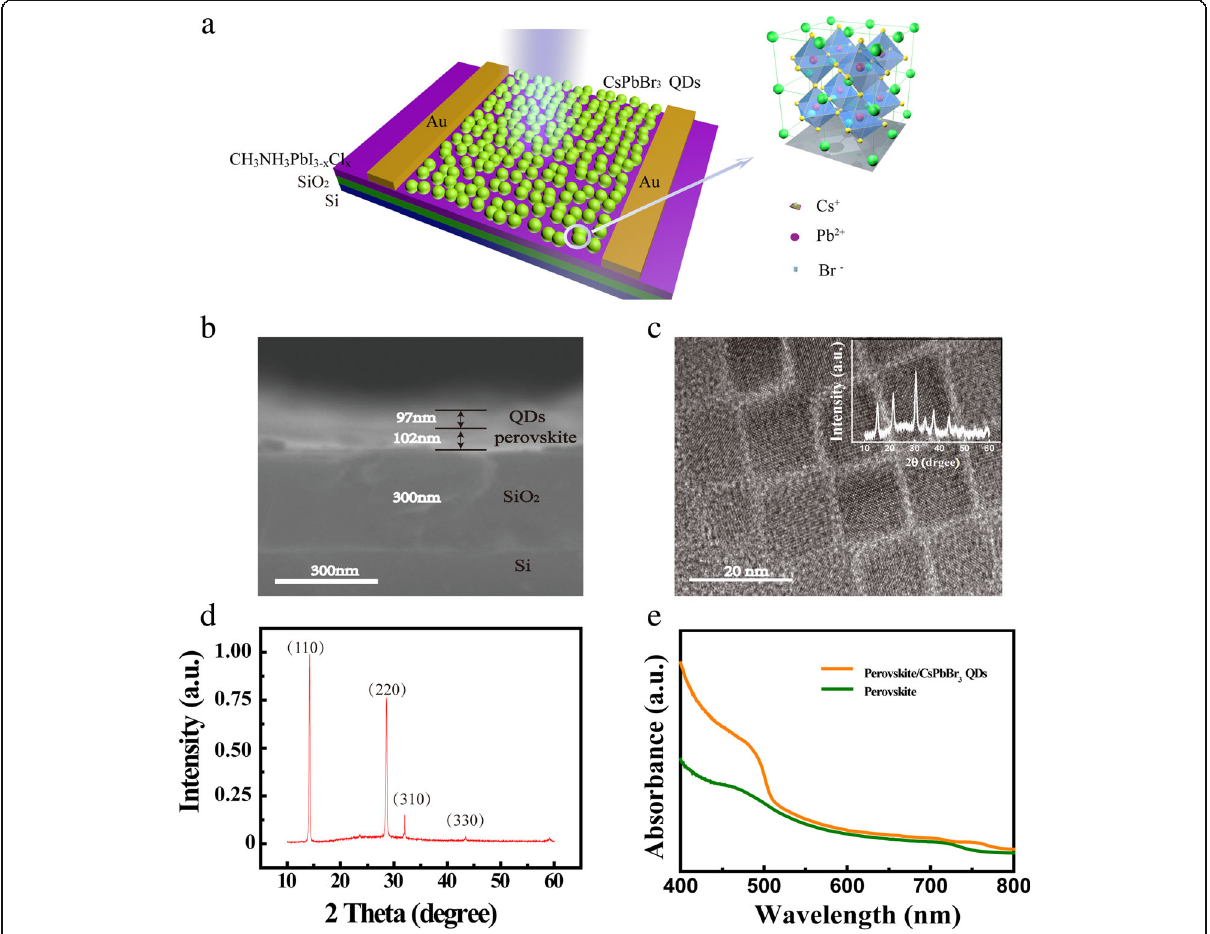
Fig. 1 Device structure and related characteristics. a Schematic of CCPD. b Cross-sectional SEM image of the photodetectors with a scale of 500nm. c TEM image of CsPbBr 3 QDs with a scale of 20nm, the inset is XRD spectrum of CsPbBr 3 QDs. d XRD spectrum of CH 3 NH 3 PbI 3 − x Cl x perovskite film. e Optical absorption spectrum of